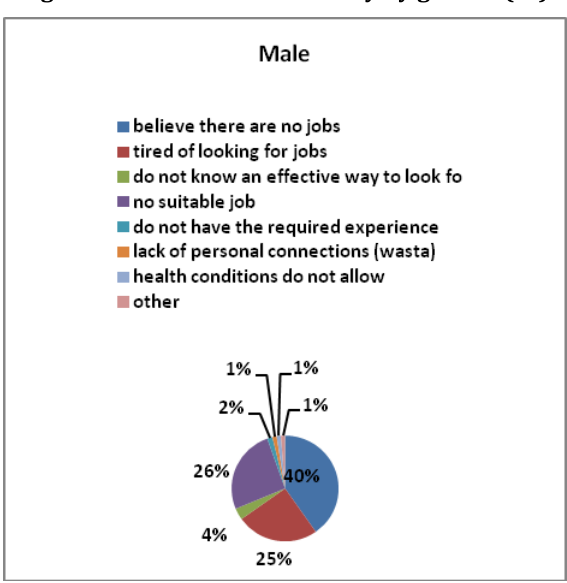
Figure 13: Reasons of inactivity by gender (%)